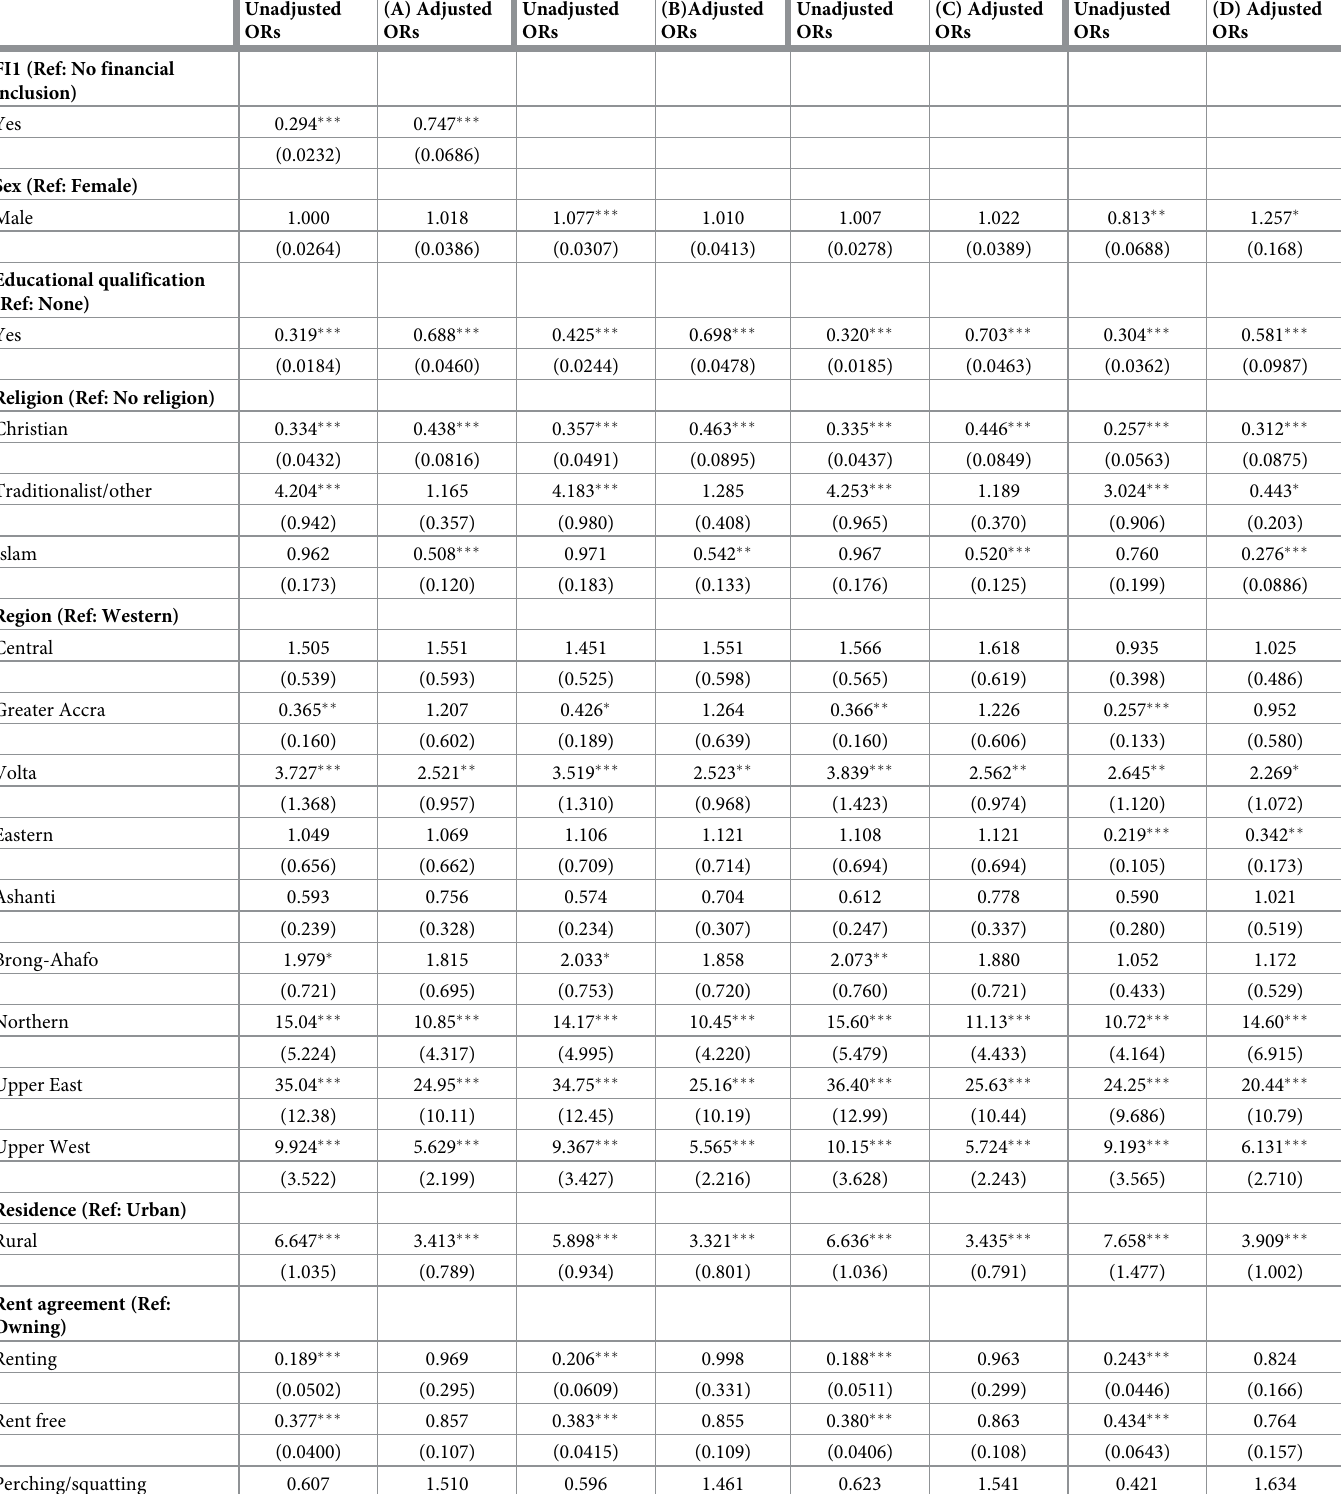
Table 2. Logistic regressions: Effect of financial inclusion on open defecation. Unadjusted